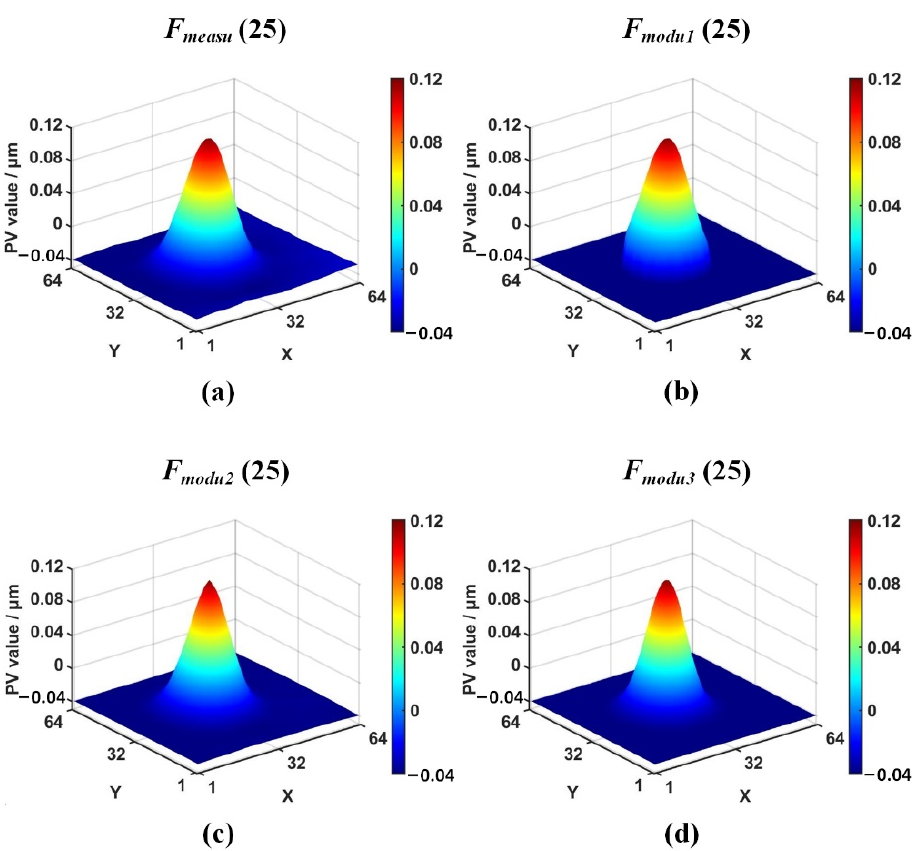
Figure 12. From the measured IF ( a ) F measu , the filtered IFs ( b ) F modu 1 , ( c ) F modu 2 , ( d ) F modu 3 for the Figure 12. From the measured IF ( a ) 𝐹 (cid:3040)(cid:3032)(cid:3028)(cid:3046)(cid:3048) , the filtered IFs ( b ) 𝐹 (cid:3040)(cid:3042)(cid:3031)(cid:3048)(cid:2869) , ( c ) 𝐹 (cid:3040)(cid:3042)(cid:3031)(cid:3048)(cid:2870) , ( d ) 𝐹 (cid:3040)(cid:3042)(cid:3031)(cid:3048)(cid:2871) for Figure 12. From the measured IF ( a ) 𝐹 (cid:3040)(cid:3032)(cid:3028)(cid:3046)(cid:3048) , the filtered IFs ( b ) 𝐹 (cid:3040)(cid:3042)(cid:3031)(cid:3048)(cid:2869) , ( c ) 𝐹 (cid:3040)(cid:3042)(cid:3031)(cid:3048)(cid:2870) , ( d ) 𝐹 (cid:3040)(cid:3042)(cid:3031)(cid:3048)(cid:2871) for the 25th actuator are achieved. 25th actuator are achieved. the 25th actuator are achieved.